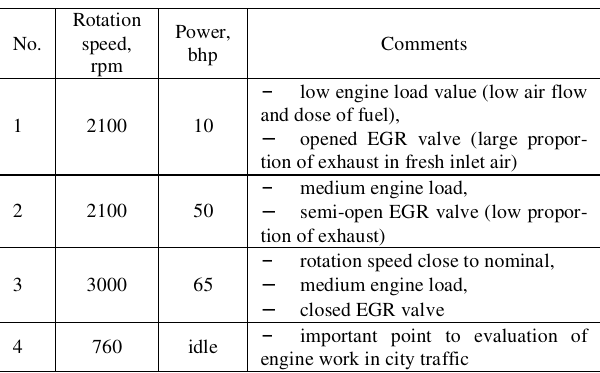
Table 1. Characteristic of points of engine operation conditions No.